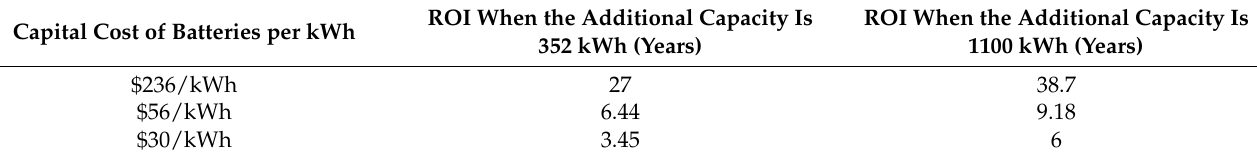
Table 6. ROI analysis when the capital cost of batteries per kWh